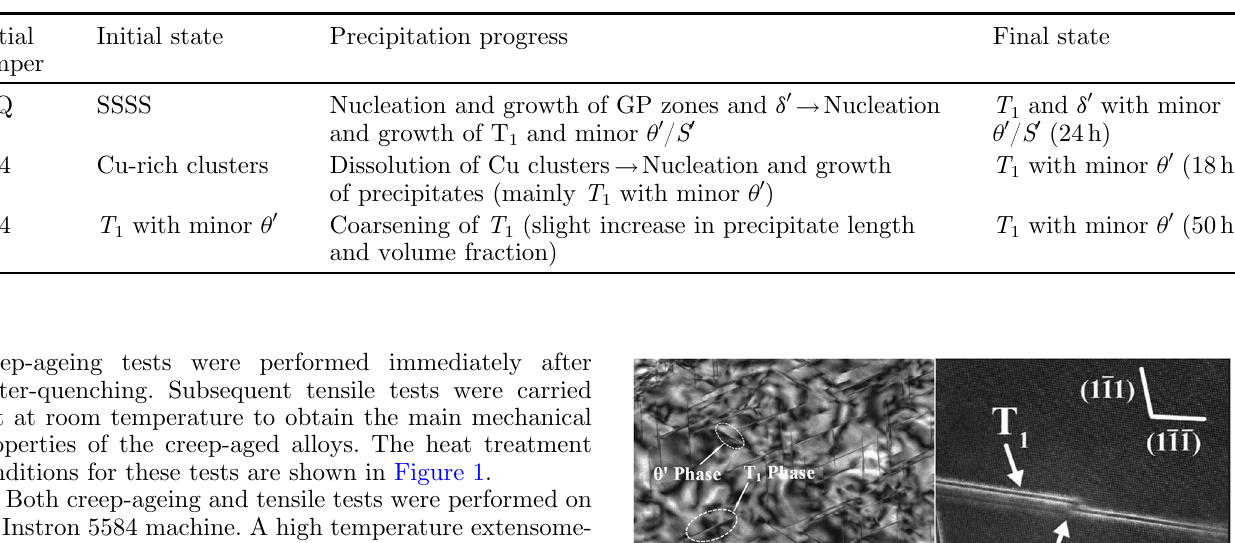
Table 3. Summary of precipitation progress during arti fi cial-ageing/creep-ageing of AA2050 with WQ, T34 and T84 initial tempers at 155 ° C (summarised from [6,13,16,19]).